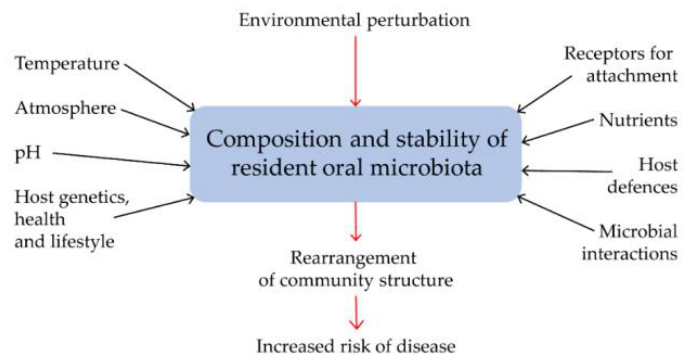
Figure 1. Host factors that affect the microbial composition, activity and stability of the oral microbiota [66]. A change in a key environmental factor can disrupt the natural balance of a resident microbiota (microbial homeostasis) and can lead to a rearrangement of the structure and activity of the microorganism community; such a change may make the site in the oral cavity prone to disease outbreaks.